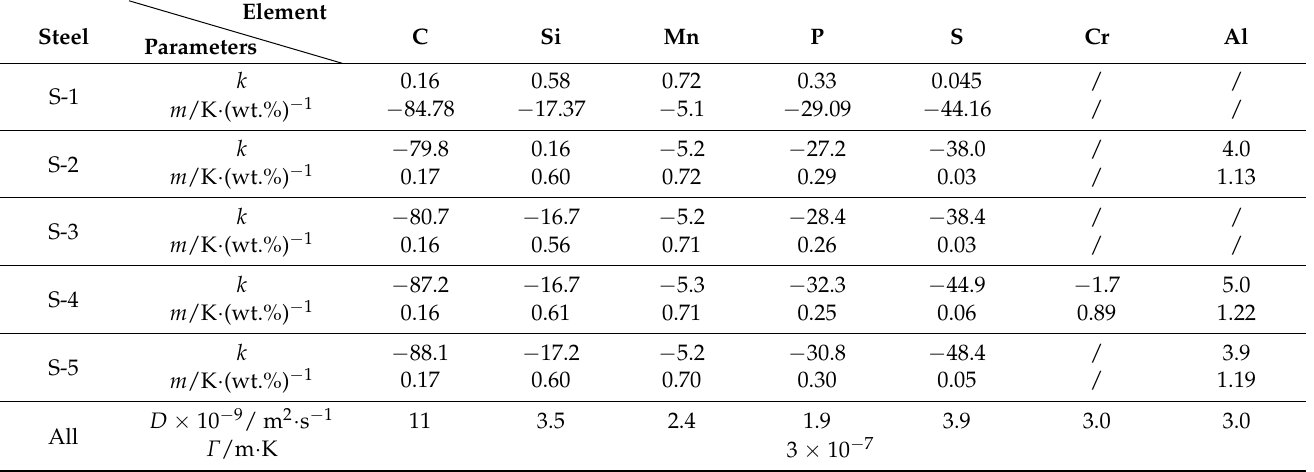
Table 3. Liquidus slope, solute partition coefficient, diffusion coefficient, and Gibbs–Thompson coefficient of binary Fe-X steels.